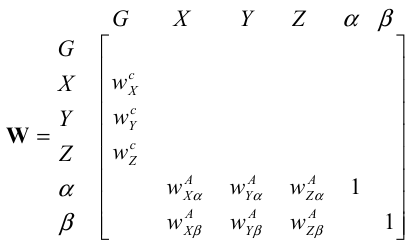
Figure 8. Super matrix for the 3-level standard AHP model.